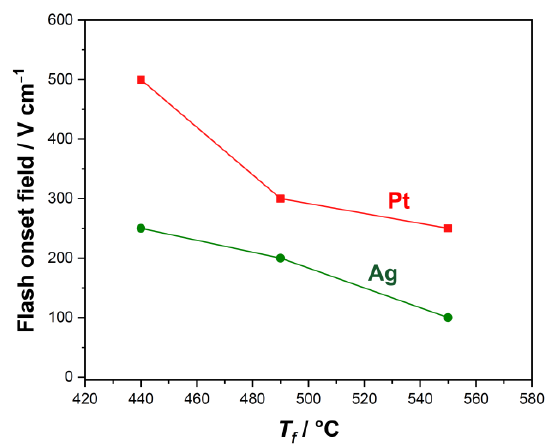
Figure 3. Flash onset field triggering a dielectric breakdown as a function of the applied electrode configuration and the experimental temperature (error < 50 V cm − 1 ).